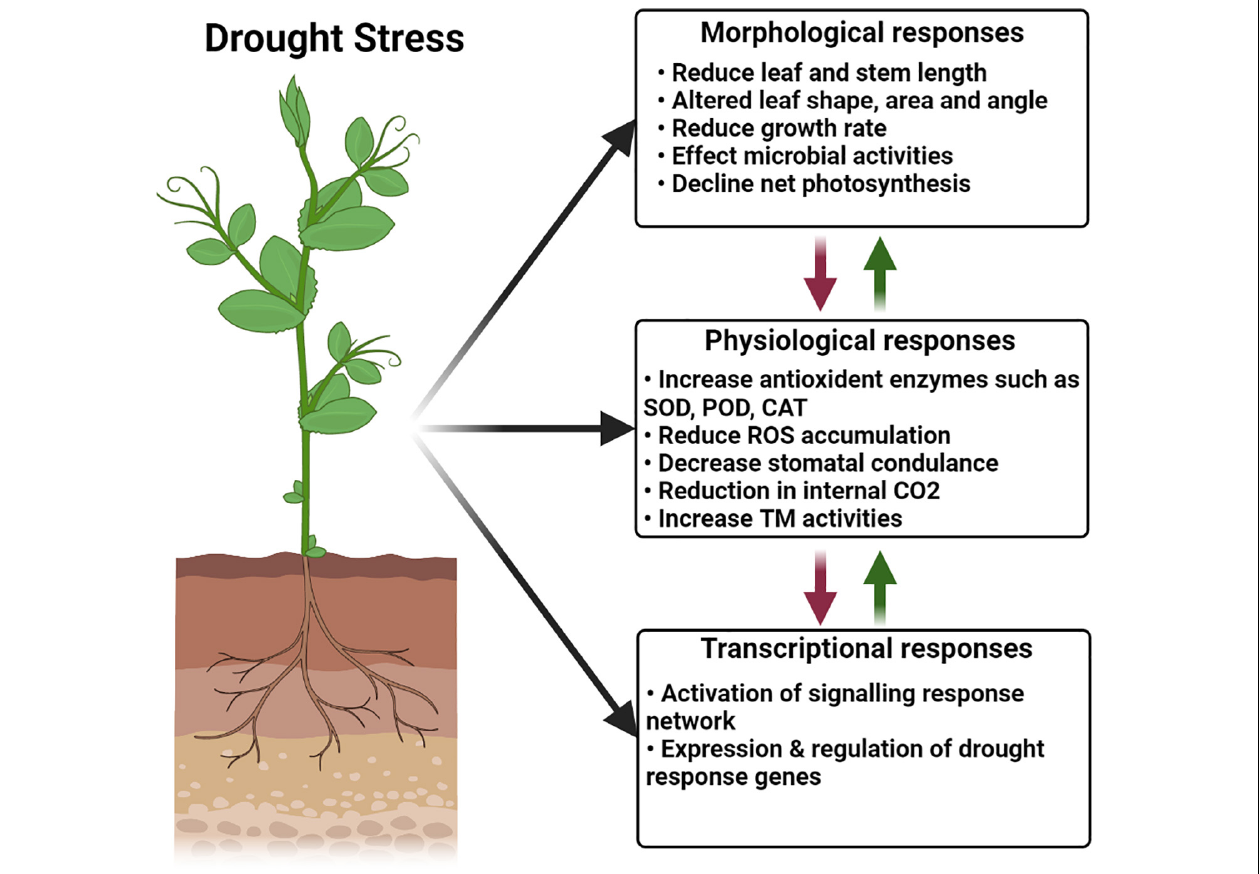
FIGURE 2 | Various mechanisms are adopted by PGPR to eliminate drought